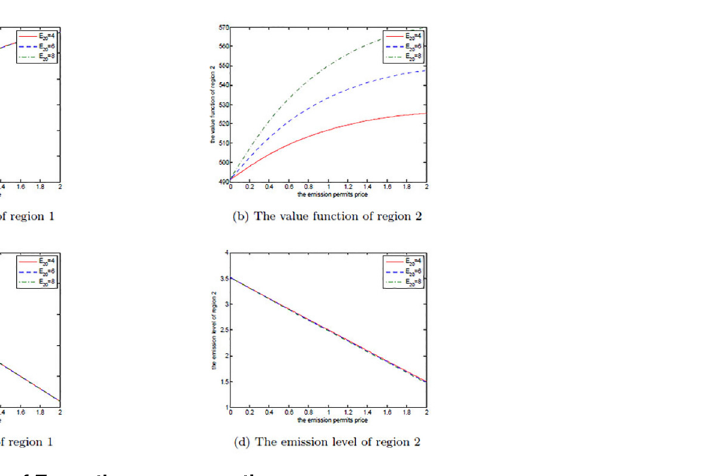
Fig 17. The effects of E 20 on the noncooperative game.